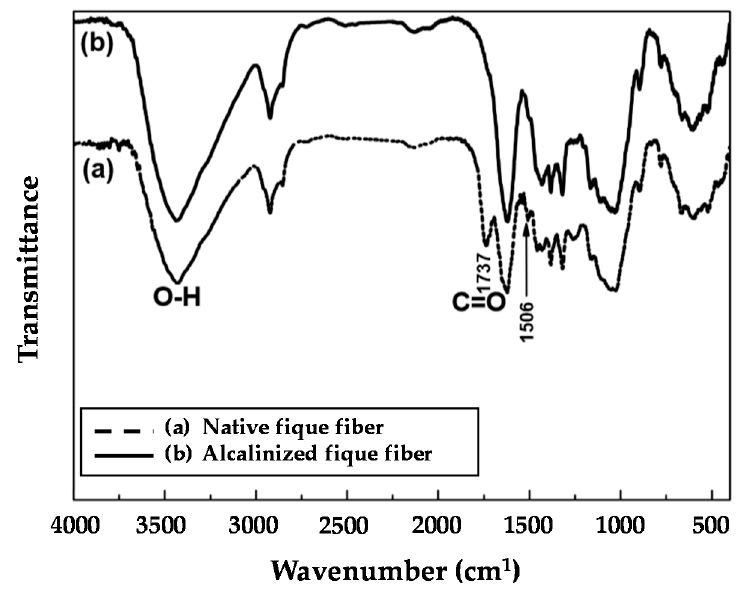
Figure 3. Fourier Transform Infrared Spectroscopy (FTIR) for the fique fibers: ( a ) native; ( b ) alkalized.